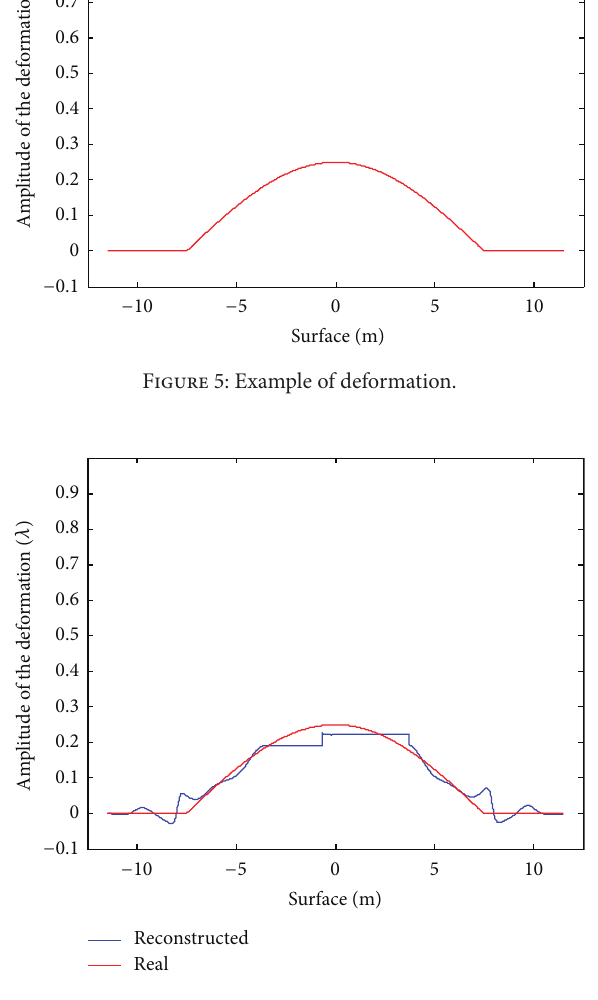
Figure 6: Surface deformation reconstructed (blue line), real surface deformation (red